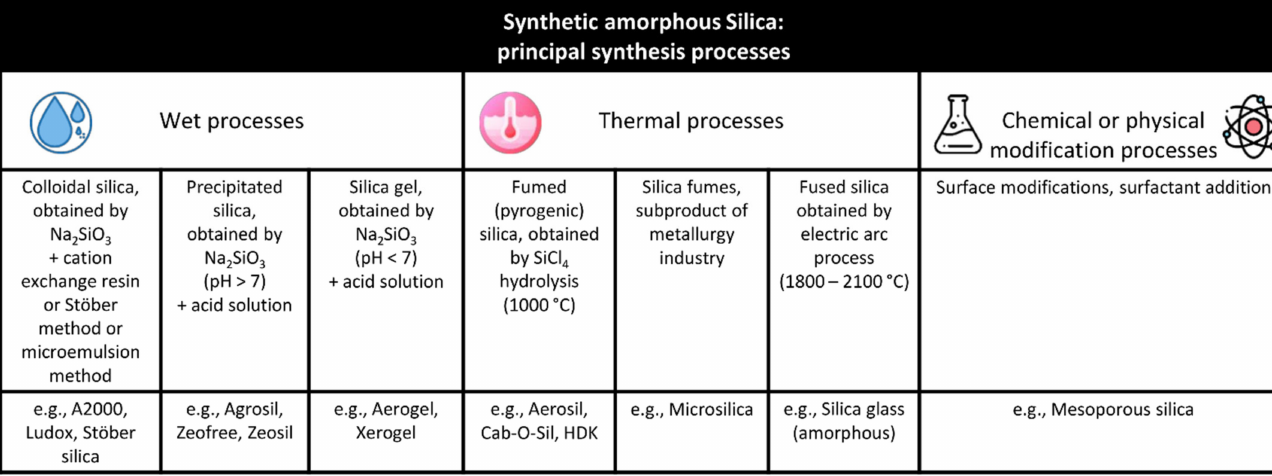
Figure 1. Processes by which amorphous silica is